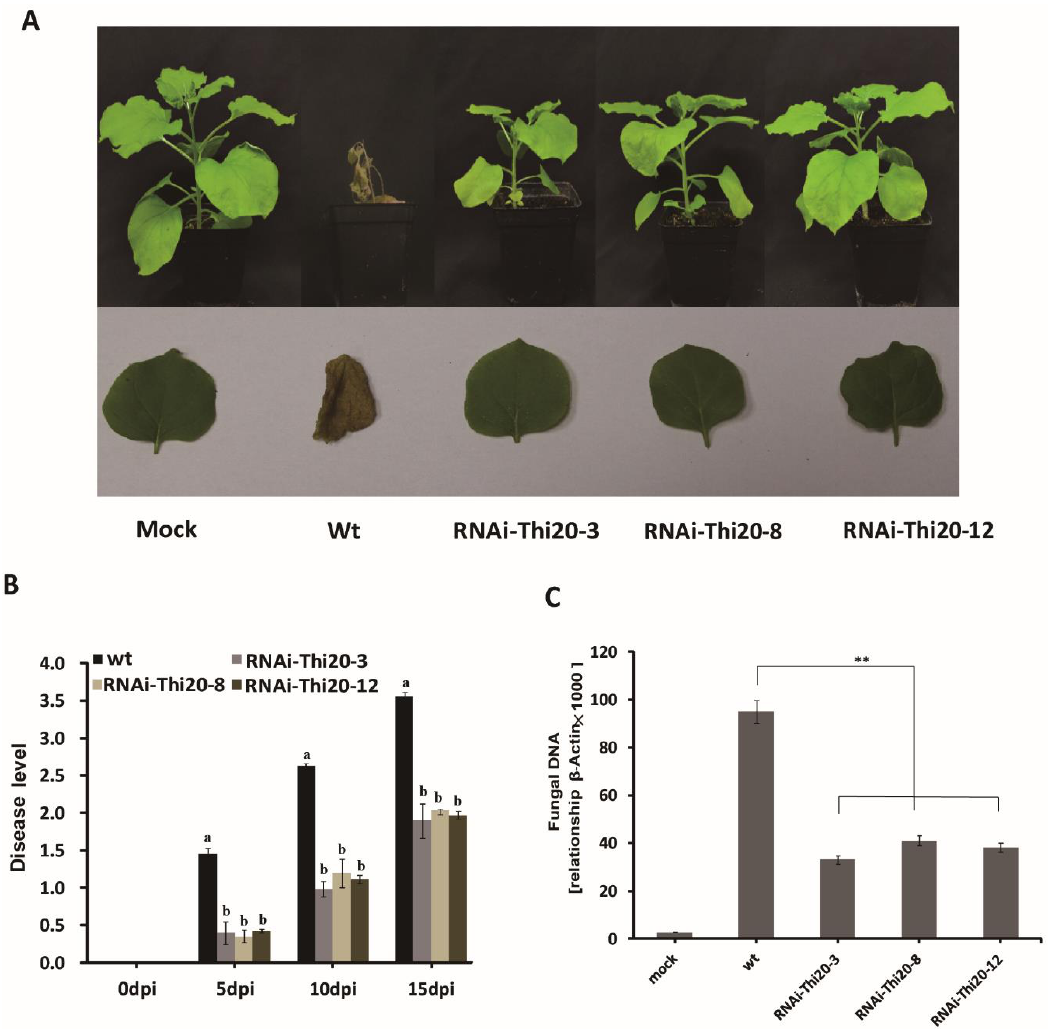
Figure 9. Virulence analysis of the Vd-wt strain in wild-type and transgenic N. benthamiana lines (RNAi-THI20-3, RNAi-THI20-8, and RNAi-THI20-12). ( A ) Virulence phenotypes of wild-type and transgenic N. benthamiana lines and representative leaves. ( B ) Disease level of wild-type and transgenic N. benthamiana lines after a 2-min root dpi in conidia of Vd-wt at 5, 10, and 15 dpi. ( C ) Fungal DNA concentration in wild-type and transgenic N. benthamiana hypocotyls infected with Vd-wt at 12 dpi. N. benthamiana seedlings inoculated with tap water (mock) as a control. Values represent the mean ± standard deviation from three independent replicates. Asterisks (**) indicate significant differences by Student’s t test at P < 0.01.